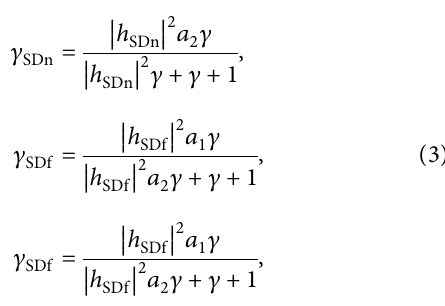
where a transmission power. a cients of Df and Dn, respectively. a